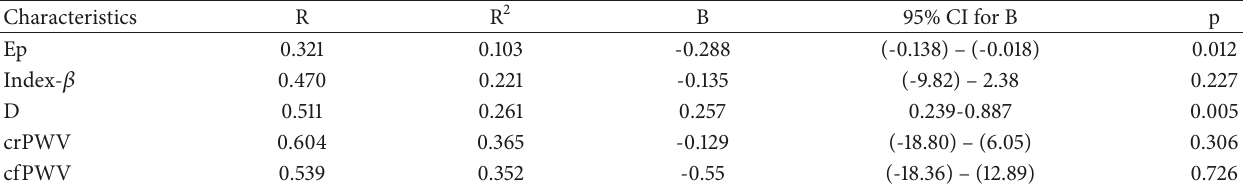
Table 5: Parameters of multiple regression analysis.